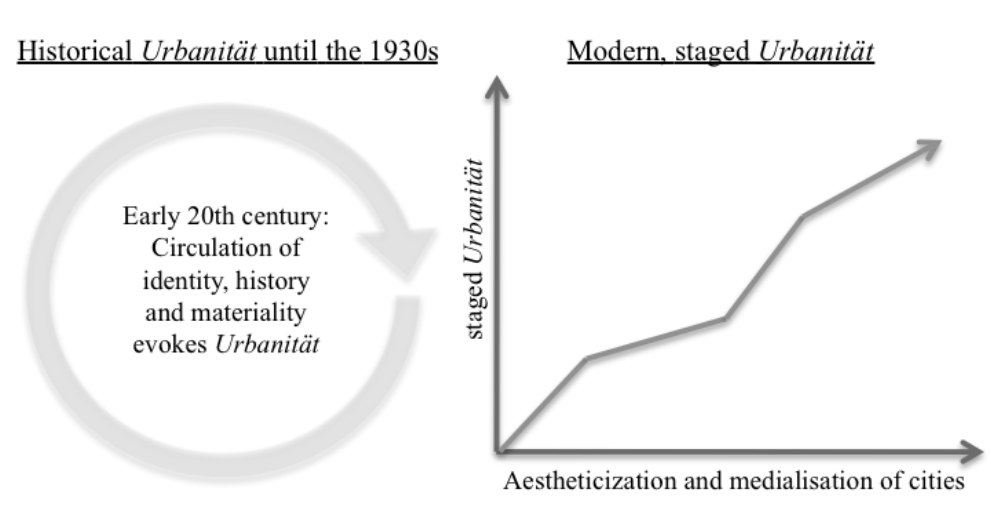
Figure 1. Change of Urbanität in Germany from the 19th century until